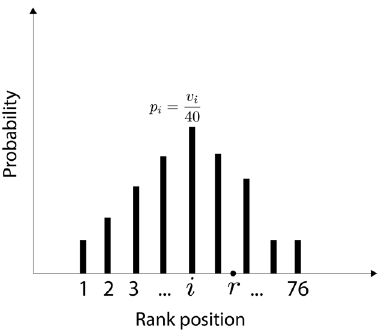
Figure 1. Probability distribution of rank position for one streetscape. This probability distribution describes how one specific streetscape was ranked by the participants. The v i is the number of times the image was located by the subjects at position i . Considering 40 subjects, the probability of the image to be ranked at any specific v i . The point r represents the mean of the distribution. position i is p i ~ 40 Notice that there are 76 possible positions due to the two additional positions for group